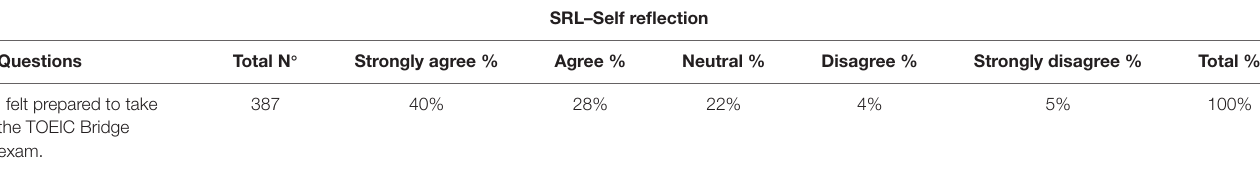
TABLE 6 | Survey results for self-regulated learning